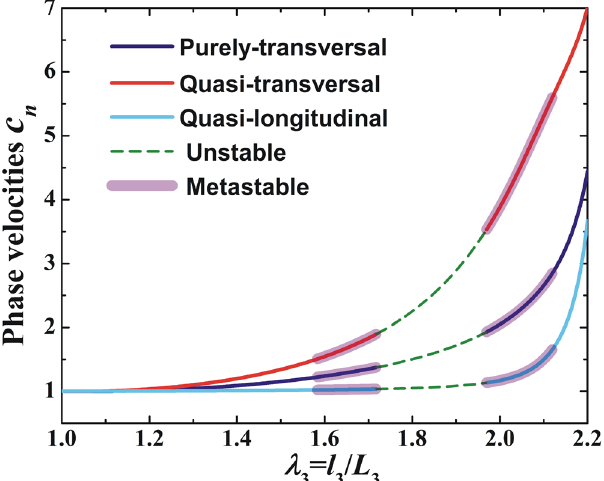
Figure 5. Normalized phase velocities of purely-transversal, quasi-transversal and quasi-longitudinal waves plotted as functions of out-of-plane stretch in the direction = n [0 3/2 1/2] . Dashed lines represent unstable region, and metastable region is identified by applying the Maxwell rule.